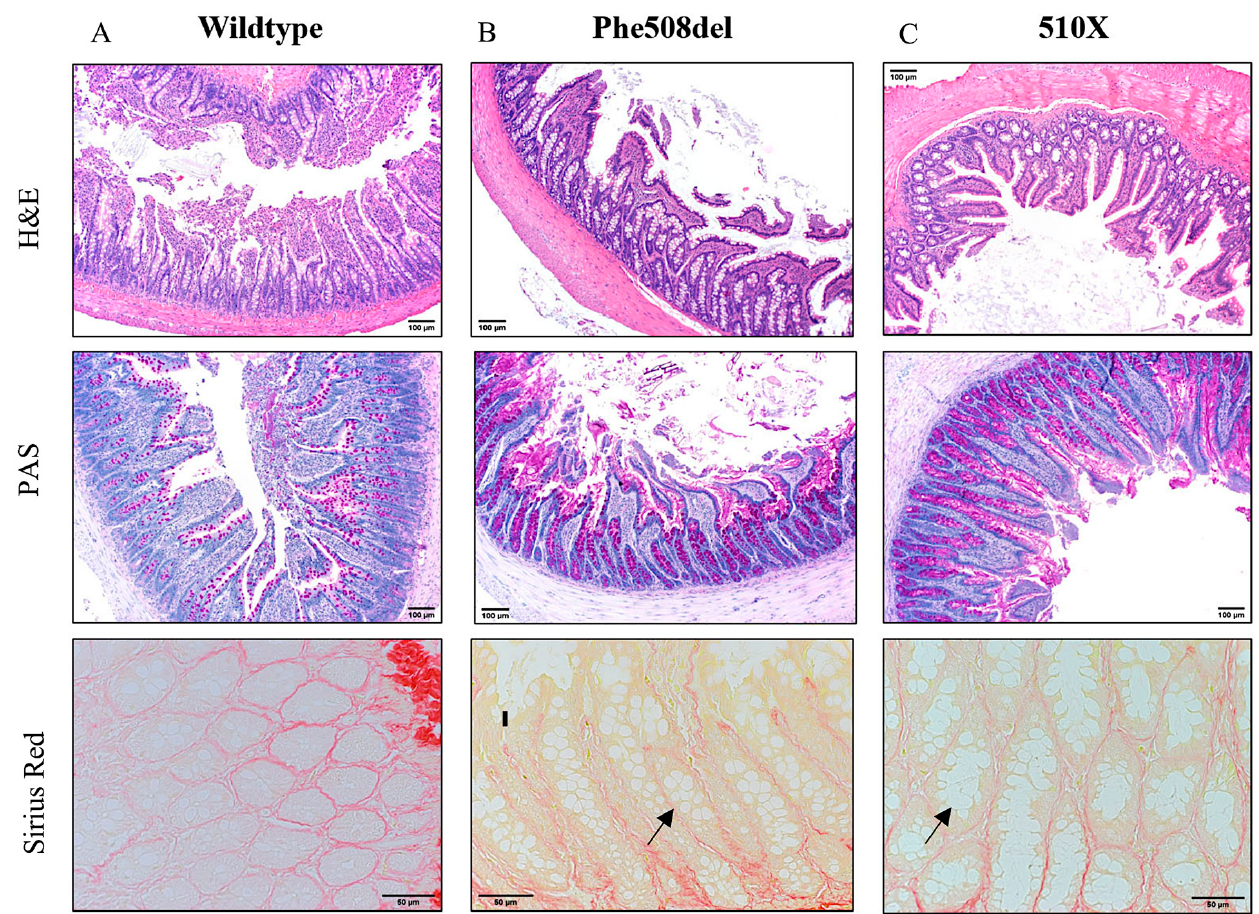
Figure 3. Histology in the ileum tissue of CF rat models. ( A ) Wild-type rats, ( B ) Phe508del rats, and ( C ) 510X rats. Scale bar is 100 µ m ( A , B ) or 50 µ m ( C ). n = 6. Arrows indicate mucus accumulation.